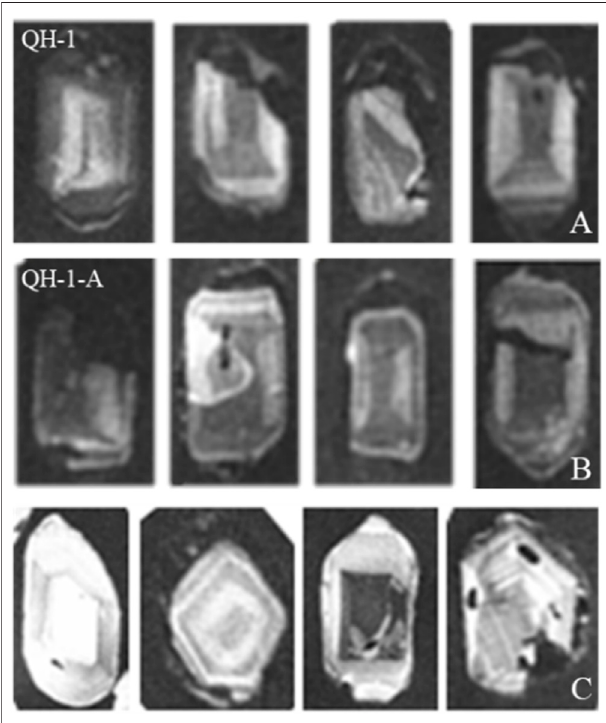
FIGURE5| CLimagesofzirconinparagneiss( (A) QianheQH-1sample, (B) Qianhe QH-1-A sample, (C) XX4-1 thick-layered paragneiss sample and XX4-2 thin-layered paragneiss sample from the north of Xinxian county).